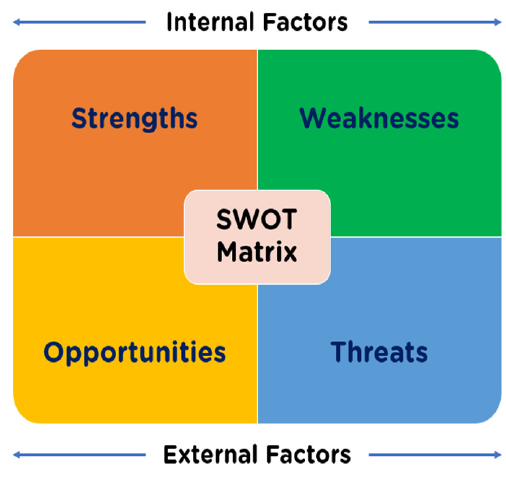
Figure 4. SWOT Figure 4. SWOT matrix.